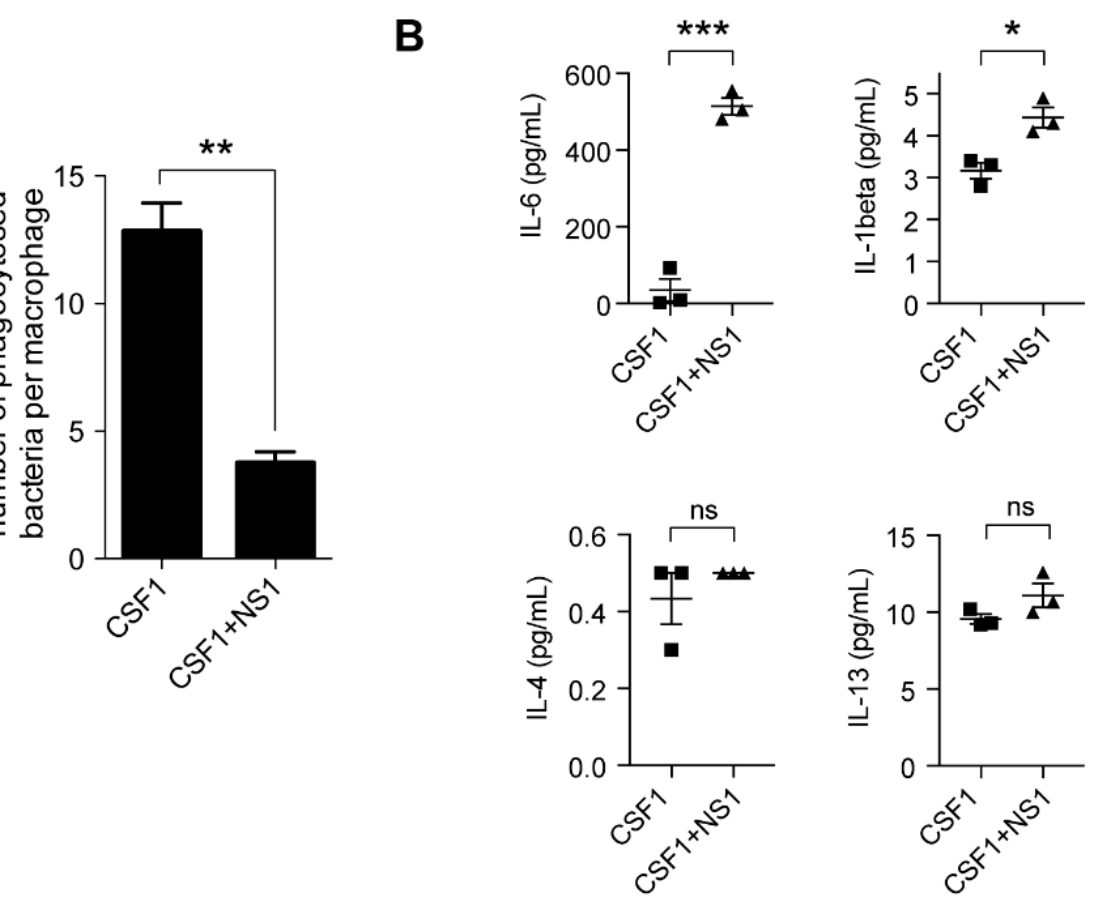
Figure 2. NS1 changes the bacterial uptake and the cytokinic profile of CSF1-treated monocytes. ( A ): Bacterial uptake was measured by the gentamicin protection assay in monocytes treated with 100 ng/ mL CSF1 alone or CSF1+NS1 (15 µM) during 3 days.. Mann–Whitney test. **: p < 10 − 2 ; ( B ): Inflammatory cytokines were measured in culture supernatants of human monocytes treated by CSF1 or CSF1+ NS1 at day 3. Results were expressed in pg/mL (ns, non-significant; *: p < 5 × 10 − 2 , ***: p < 10 − 3 unpaired t-test)